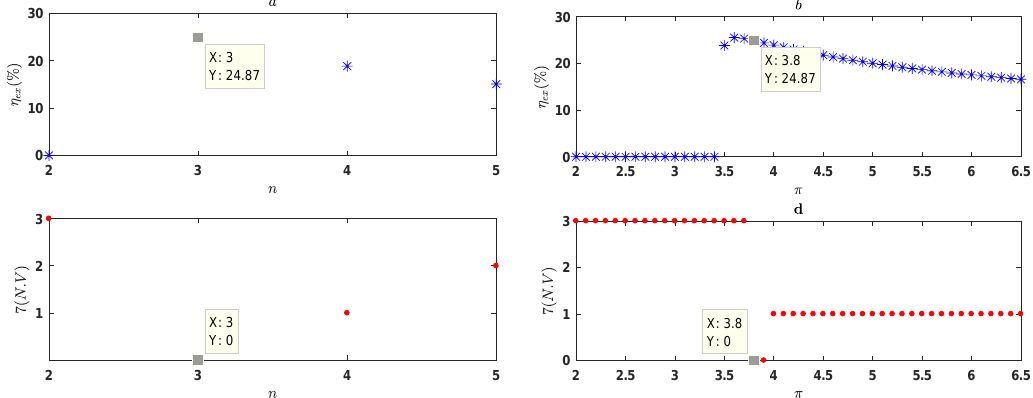
Figure 10. Variation of global exergy efficiency and number of violated constraints with number of compression stages ( a , c ) and compressor pressure ratio ( b , d ) at optimal